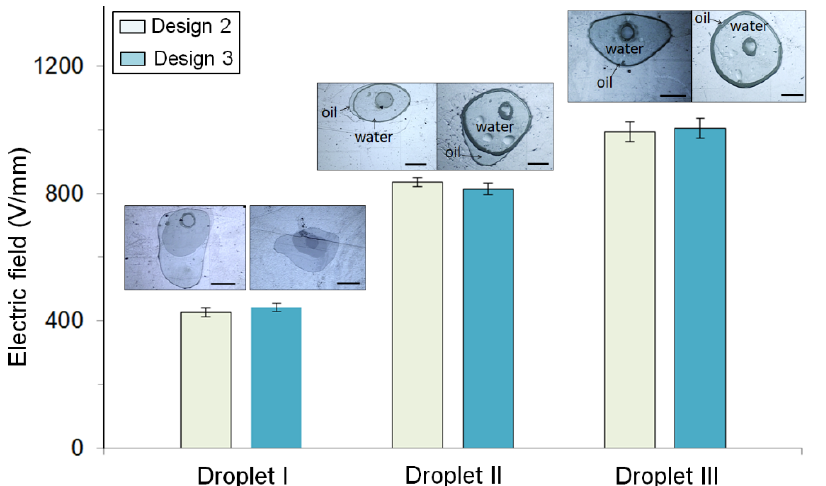
Figure 5. The minimal electric field required to move the droplet from the suspended to the final stage for droplet insertion. The images were taken when the droplets were inserted into the orifices and moved onto the bottom plates. As the droplets could not complete the droplet insertions on some of the terminal electrode designs, only the results from Designs 2 and 3 are shown (scale bar = 1 mm).